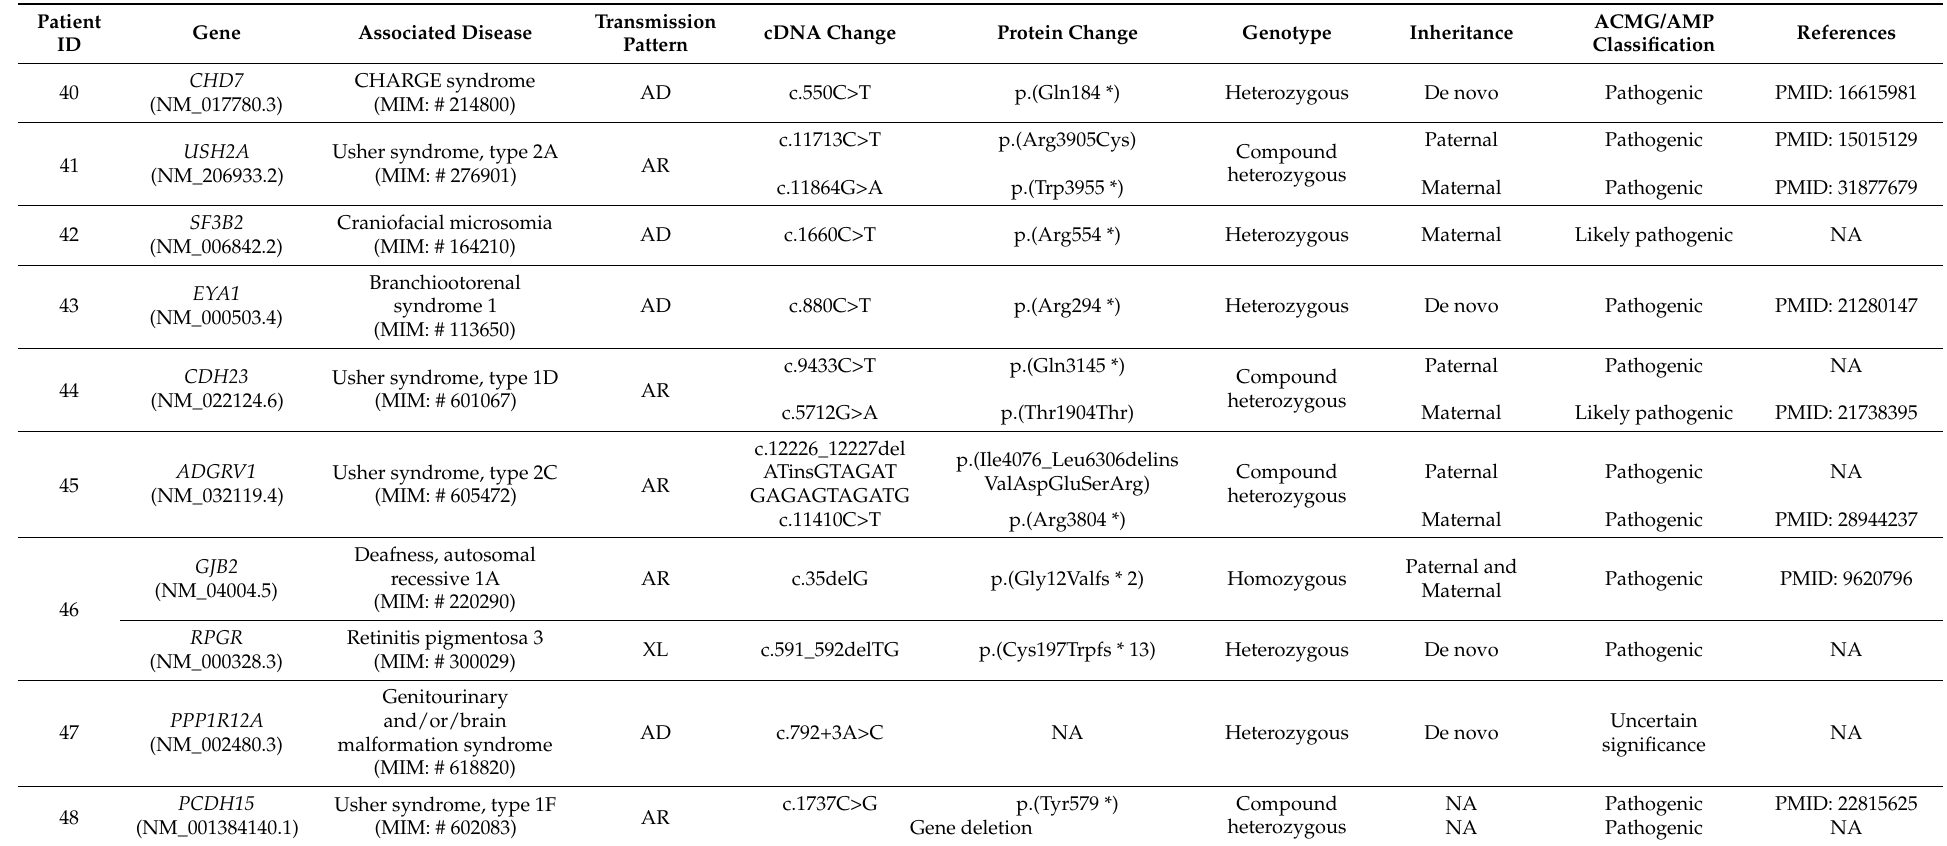
Table 4. Variants identified through WES analysis in SHL patients. Gene: list of genes carrying the identified variants with NCBI RefSeq accession number of the considered protein-coding transcripts (NM_). Associated disease: genetic disorder nomenclature according to the Online Mendelian Inheritance in Man ® (OMIM ® ) database. Transmission pattern: AD: autosomal dominant; AR: autosomal recessive; XL: X-linked. cDNA change and Protein change: variant description according to the Human Genome Variation Society (HGVS) nomenclature guidelines. Genotype: homozygous: the same variant is present on both alleles; heterozygous: the variant affects only one allele; compound heterozygous: two different variants are present on each allele. Inheritance: inheritance pattern of every identified variant established after parental segregation. ACMG/AMP classification: variant pathogenicity according to ACMG/AMP guidelines. References: PubMed unique IDentifier (PMID) of publications reporting each variant. *: stop codon. NA: not